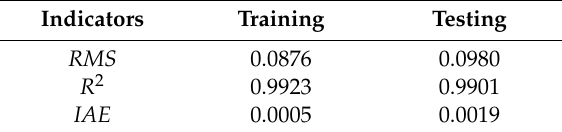
Table 5. The indicators of training and testing of Compressive strength ANN model.